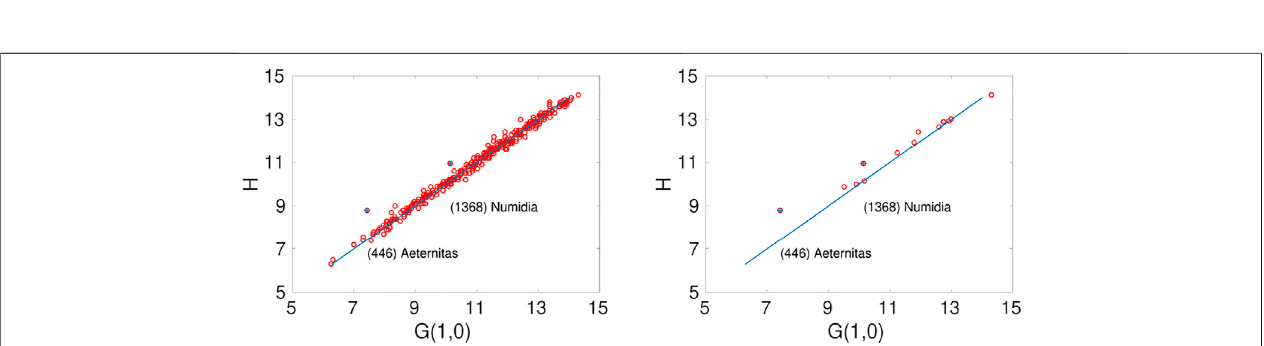
FIGURE 6 | Comparison of the derived equal-sphere G-band absolute magnitudes G (1,0) and the V-band absolute magnitudes H based on the Jet Propulsion Laboratory Small-Body Database for 358 asteroids (left), the right panel highlighting the 13 new asteroids. The blue line represents perfect correlation of the absolute magnitudes. Two noticeable outliers (446) Aeternitas and (1368) Numidia are marked with blue crosses.